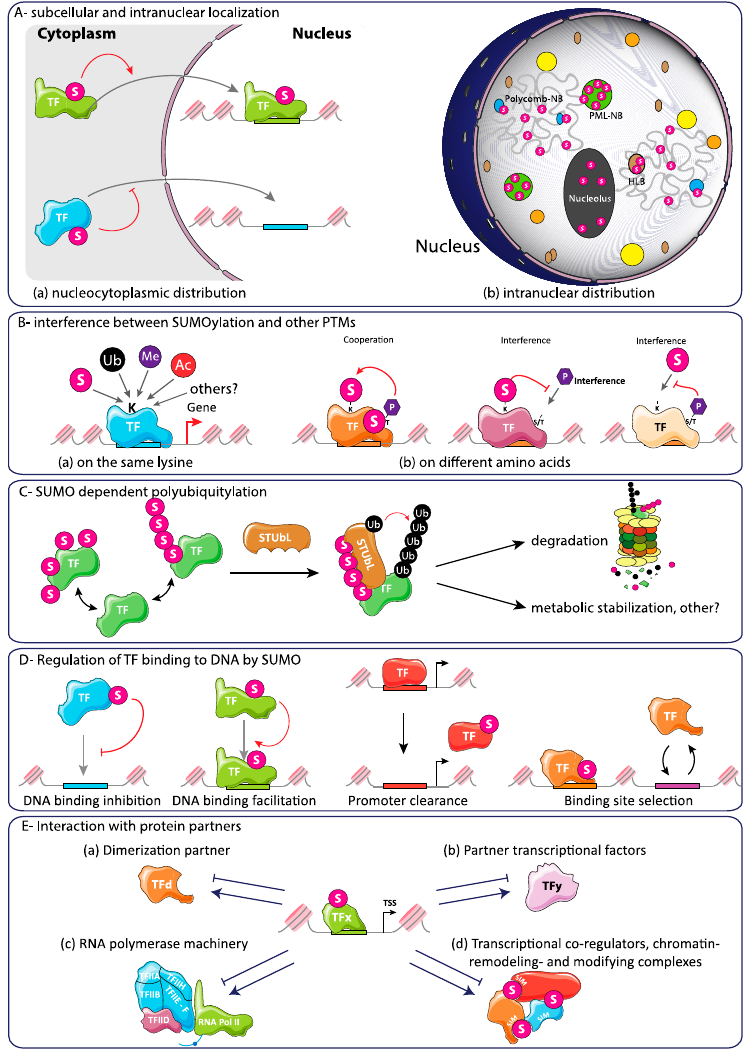
Figure 3. Alteration of transcription factor properties by SUMOylation. SUMOylation can alter various properties of TFs at various stages of their actions and/or their lifetime and in a finely tuned manner. ( A ) Subcellular and intranuclear localization. SUMOylation can control nucleo-cytoplasmic shuttling of certain TFs ( a ), as well as their addressing to the various intranuclear subcompartments, including chromatin, PML bodies, Polycomb bodies, histone locus bodies, nucleoles and Cajal bodies ( b ). ( B ) Interferences with other post-translational modifications. SUMOylation can cross-talk with other post-transcriptional modifications that control transcriptional activity and/or protein fate. For example, SUMOylation, ubiquitylation and acetylation can compete for the modification of the same lysines ( a ). SUMOylation can also be dependent upon certain phosphorylations and SUMOylation and phosphorylations at nearby or distant sites can exert cooperative or antagonistic effects on TF activity ( b ). ( C ) SUMO-dependent polyubiquitylation. PolySUMOylated or multimonoSUMoylated TFs can interact with StUbLs, leading to their polyubiquitylation. This can lead to subsequent addressing to the proteasome but also, sometimes, to protein stabilization. ( D ) Binding and release from DNA/chromatin. SUMOylation of TFs can alter binding to and clearance from their TFBSs in various ways. SUMOylation of chromatin-bound TFs can also participate in TFBS selection via releasing TFs from less affine TBFSs. ( E ) Interaction with partners. SUMOylation can also alter positively or negatively TF interactions with their protein partners with varied effects on transcriptional outcomes. These include: homo or heterodimerization in the case of dimeric TFs ( a ), interactions with other TFs ( b ) transcriptional machineries ( c ) and various kinds of transcriptional coregulators or chromatin-modeling and modifying complexes ( d